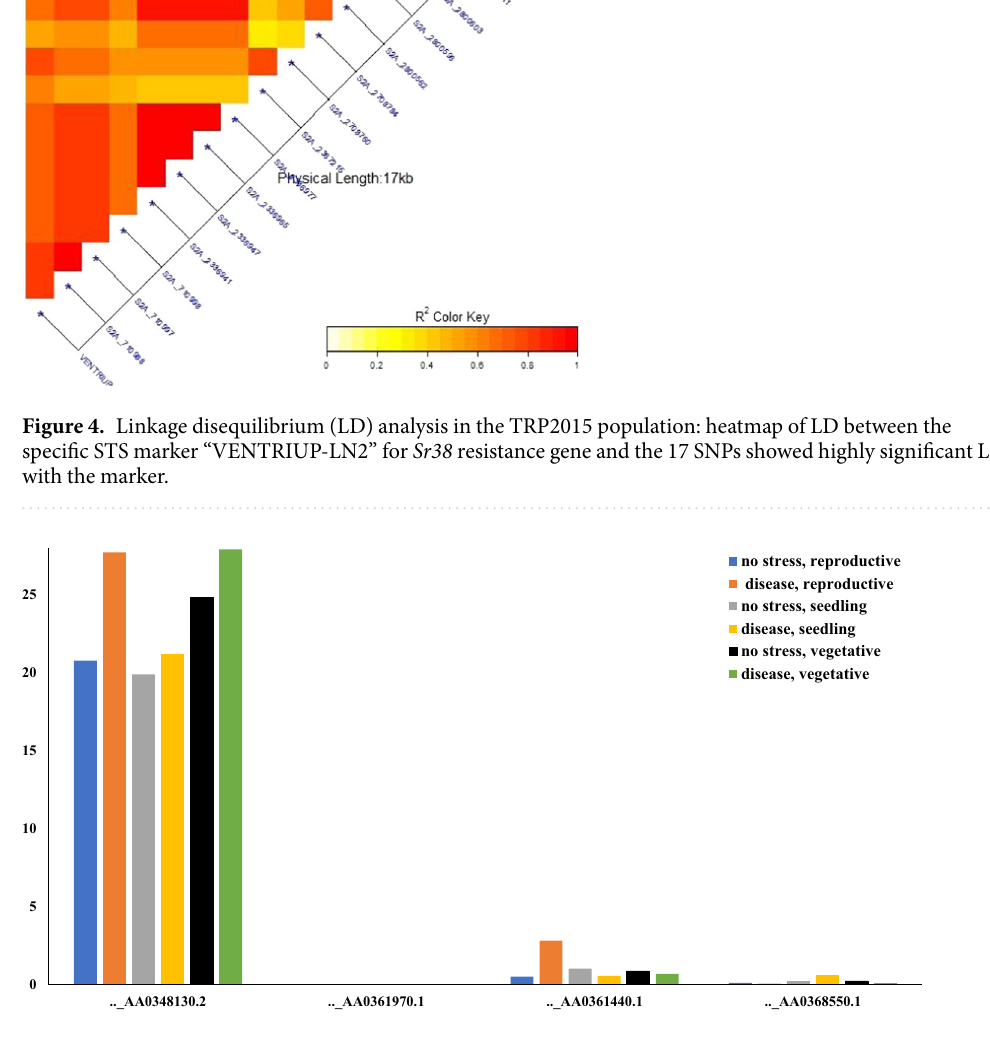
Figure 5. The expression of the gene models harboring SNPs significantly associated with stem rust resistance in the TRP2015 set. Blue, gray and black columns represent the gene expression under controlled conditions at reproductive, seedling and vegetative growth stages, respectively. While, orange, yellow and green columns represent the gene expression under disease infection conditions at the same growth